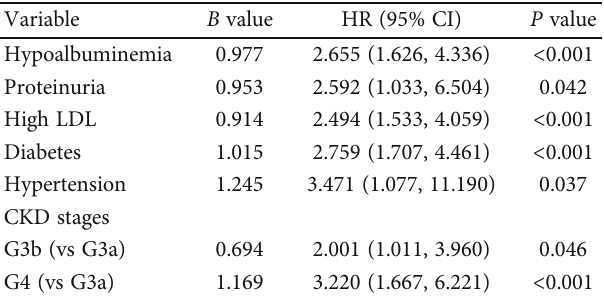
Table 4: Multivariate analysis of factors a ff ecting the progression of